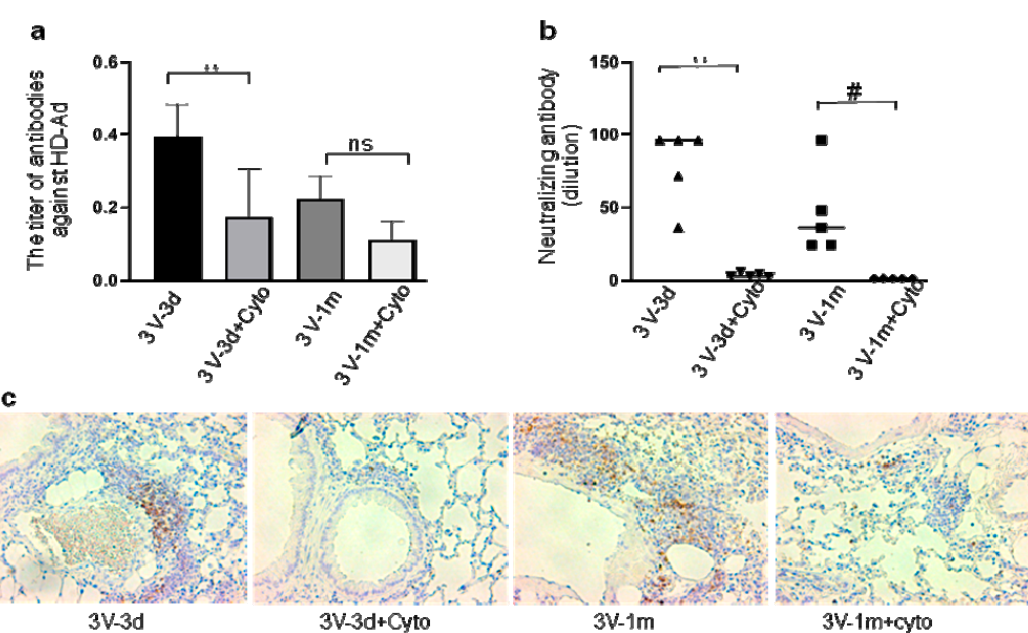
Figure 4. Host humoral immune responses to vector delivery. ( a ) The titer of anti-adenoviral antibodies in mouse bronchoalveolar lavage fluid (BALF). The total anti-Ad antibodies (IgA, IgE, IgGs, IgM) were detected with ELISA in all groups. Data were presented as mean ± SD (standard deviation). ( b ) Neutralizing antibody in mouse BALF. n = 5, #: p < 0.05; **: p < 0.01. ( c ) B-cell presence in mouse lungs. B-cells were detected in mouse lungs with antibodies against B220 by immunohistochemistry staining. The positive cells are shown in brown color. ns, no significant difference.